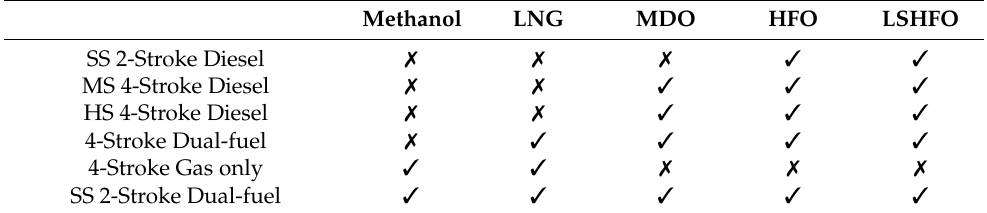
Table 1. Compatibility between types of marine engines and different